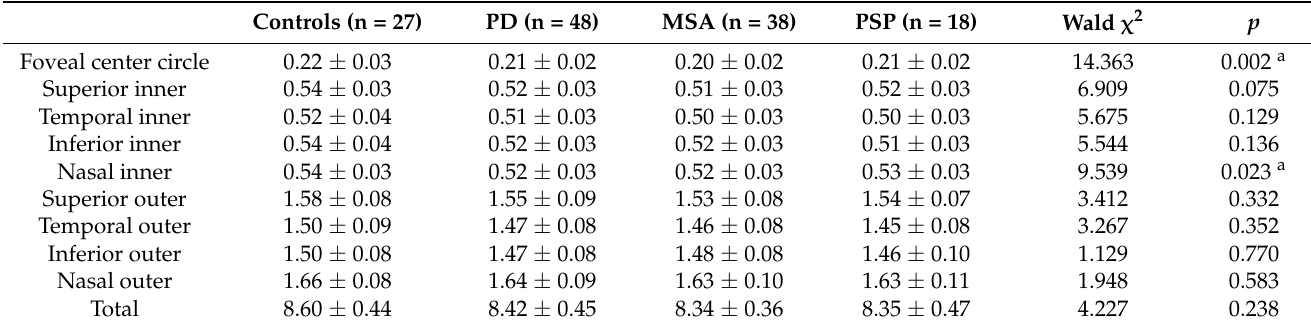
Table 6. Macular volume (mm 3 ) of PD, MSA, and PSP patients and